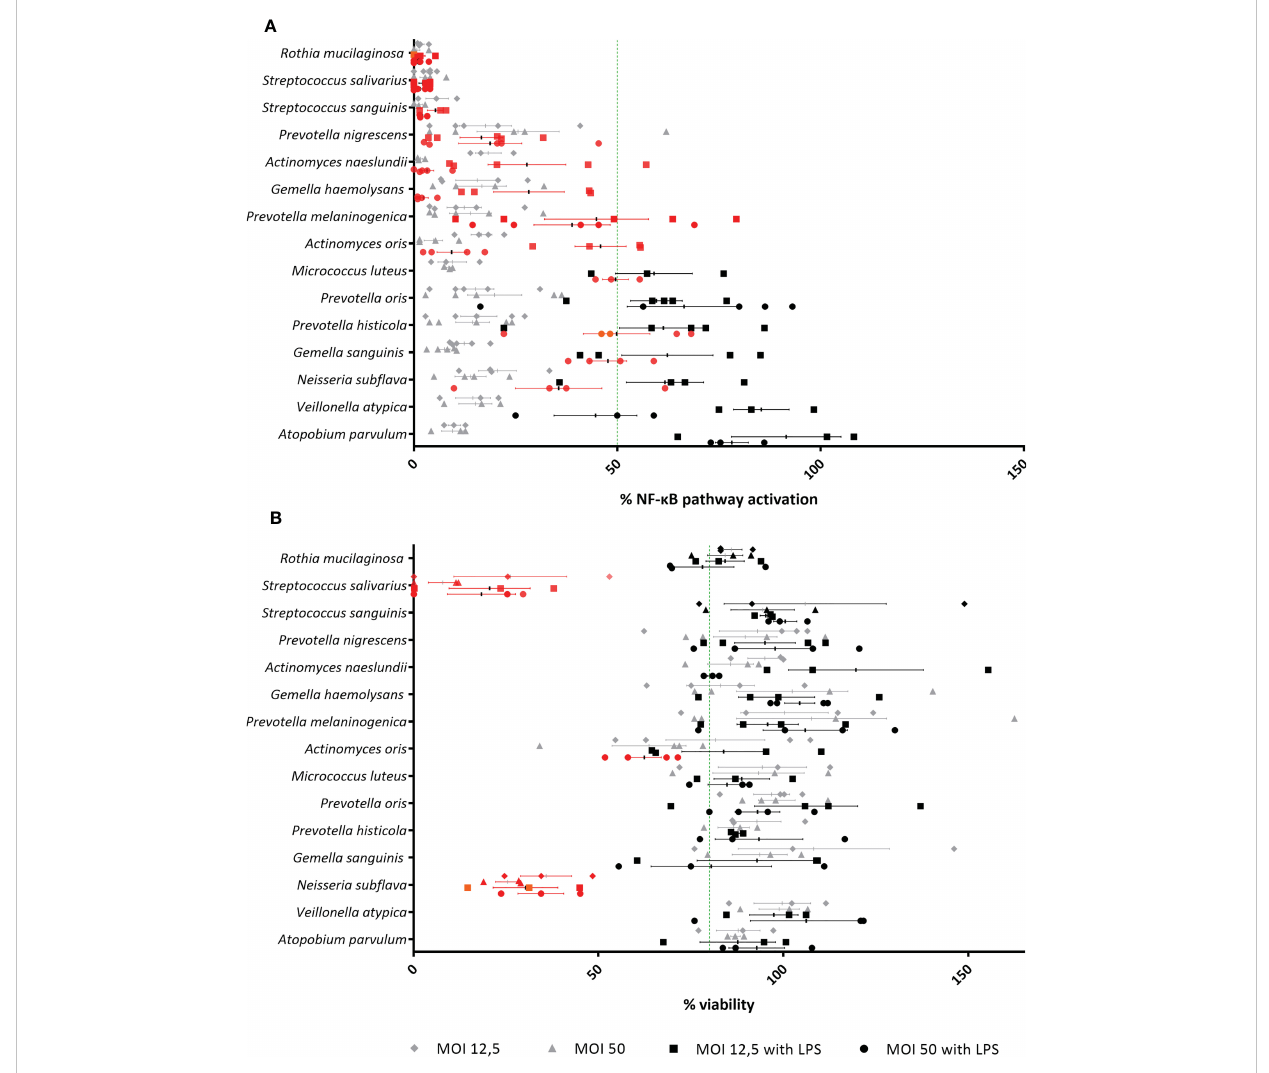
FIGURE 3 Evaluation of lung microbiota members for identi fi cation of anti-in fl ammatory and non-cytotoxic species in (3D) A549 (luciferase NF- k B-reporter) cells. (A) Isolated lung commensals at MOI 50 and MOI 12.5, with or without LPS, were screened for anti-in fl ammatory activity by a NF- k B luciferase assay. On the vertical axis, screened lung commensals are depicted, on the horizontal axis, the % NF- k B pathway activation compared to LPS- stimulated cells is shown. Anti-in fl ammatory effects were de fi ned as;< 50% NF- k B pathway activation compared to LPS-stimulated cells as visualized by a green line, p< 0.05. Anti-in fl ammatory commensals are marked in red on the graph. N ≥ 3. (B) Isolated lung commensals at MOI 50 and MOI 12.5, with or without LPS, were screened for cytotoxicity by a LDH assay. On the vertical axis, screened lung commensals are depicted, on the horizontal axis, the % viability compared to cells cultured alone is shown. Cytotoxic effects were de fi ned as;< 80% viability compared to cells cultured alone as visualized by a green line, p< 0.05. Cytotoxic commensals are marked in red on the graph. N ≥